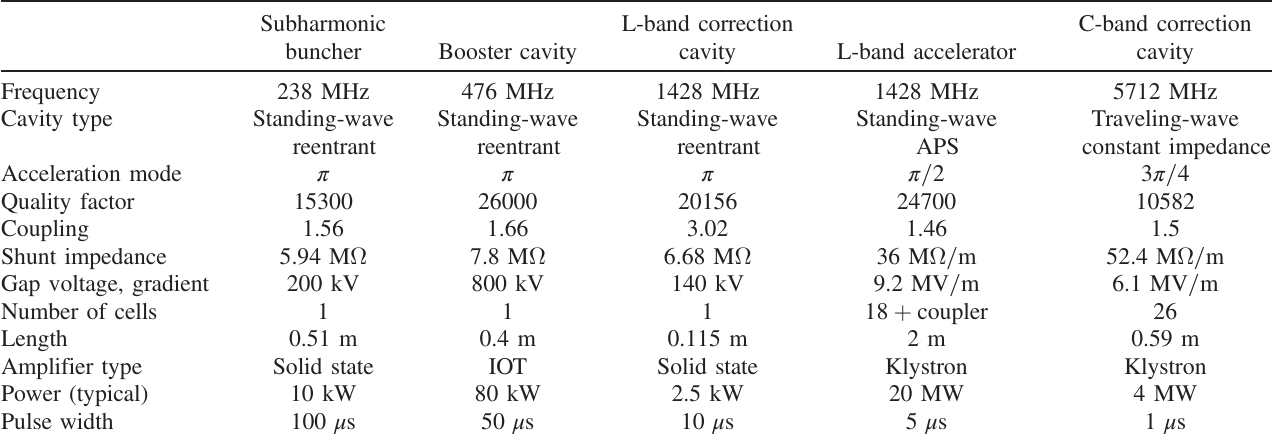
TABLE III. Main rf parameters of SACLA-injector rf cavities and power sources. Subharmonic L-band buncher Booster cavity